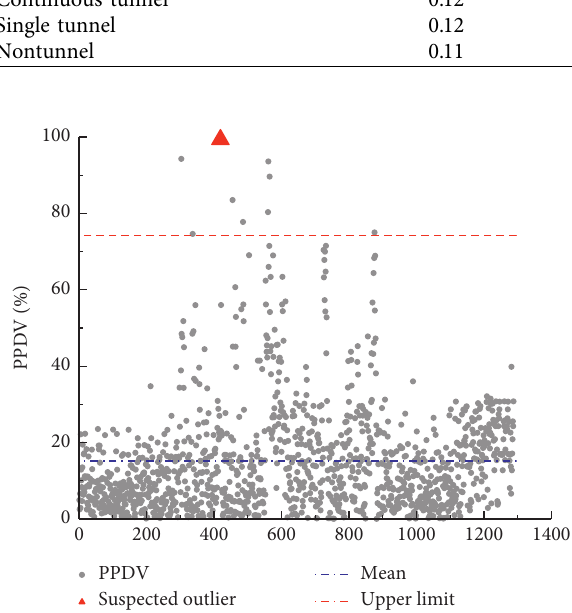
Figure 3: Results of Grubbs test (nontunnel